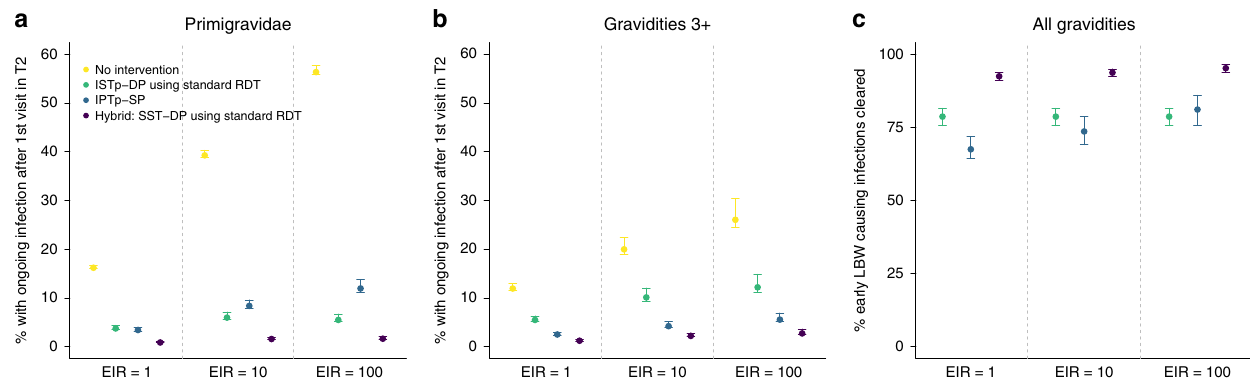
Fig. 5 The relative effectiveness of IPTp, ISTp and hybrid strategies in clearing early infection. a Shows the percentage of primigravidae with ongoing parasitaemia following their fi rst visit in second trimester if they: receive no intervention (yellow dots), are screened with a standard RDT and treated with an ACT if positive (green dots), receive SP presumptively (light blue dots), are given an ACT if RDT + and SP otherwise (hybrid strategy — dark blue dots). Error bars show 95% intervals based upon our uncertainty analysis for comparing the relative impact of intervention strategies (see “ Methods ” section), b Shows the equivalent fi gure but in women of gravidities 3 and above. c Shows the percentage of these early infections that would subsequently lead to LBW that are effectively treated based upon our modelled relationship between the detectability and severity of infection (NB: given these are ongoing infections this does not imply that treating these infections would necessarily avert all risk of LBW attributable to these infections — see “ Methods ” sction for full details).